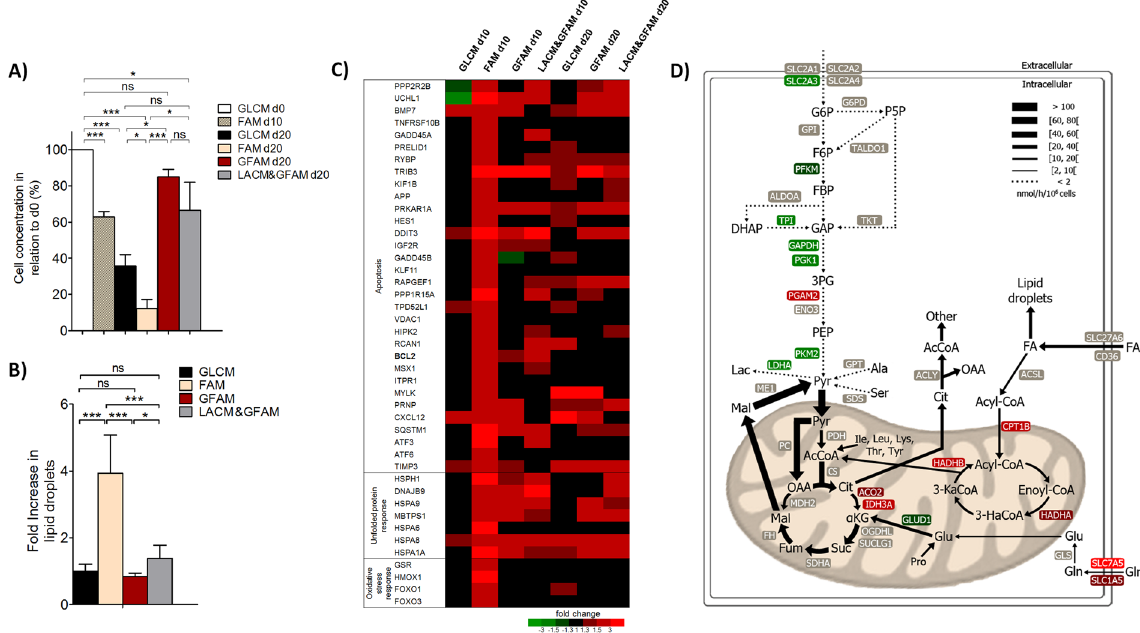
Figure 2. In the absence of a sugar source, fatty acid rich medium induces lipotoxicity in hiPSC-CMs. ( A ) Percentage of cell concentration, in all conditions tested, in relation to day 0 (d0), assessed using the Trypan Blue Exclusion Method. ( B ) Analysis of lipid droplet content using a lipid droplet-specific fluorescent dye (Nile Red) of hiPSC-CMs at day 15. Fluorescence values were normalized for the values obtained in cells cultivated in GLCM. Data are represented as mean ± SD. * p < 0.05; *** p < 0.001; ns, not significant. n ≥ 10 separate experiments. ( C ) Heat map of differentially expressed genes closely related with apoptosis, unfolded protein and oxidative stress responses in hiPSC-CMs cultivated in different culture media. Genes were considered up- or down-regulated based on a fold change in expression FC ≥ |1.3| compared to d0. Heatmap shows averaged values from n = 2. ( D ) Metabolic flux map of the central carbon metabolism of hiPSC-CMs cultivated for 10 days in FAM. The flux map was determined using non-stationary 13 C-MFA. Arrow thickness reflects flux values (see Table S1 for exact flux